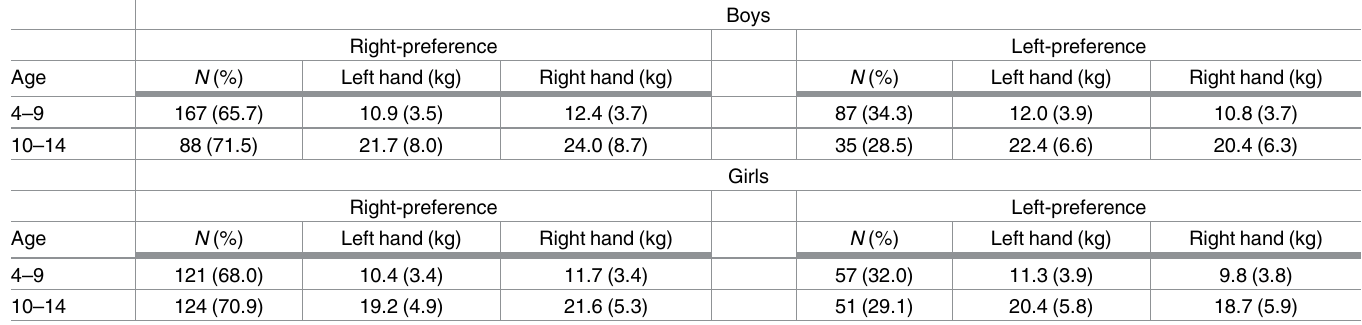
Table 2. Overview of handgrip strength data.